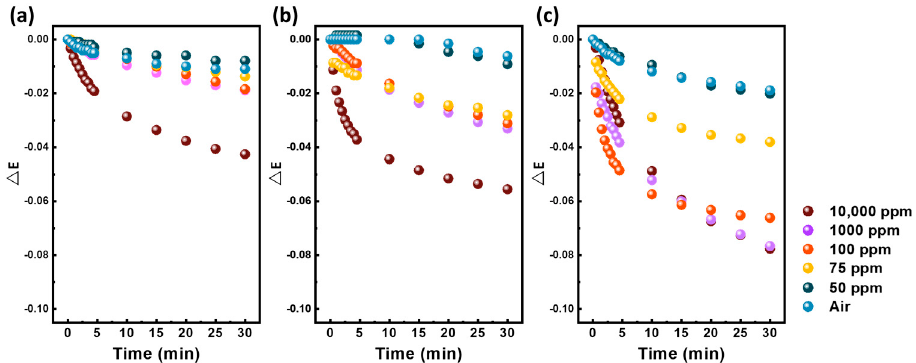
Figure 3. Extinction changes of ( a ) SnO 2 /Ag/PMMA fi bers ( b ) WO 3 /Ag/PMMA and ( c ) WO 3 /SnO 2 /Ag/PMMA sensing materials exposed to various concentrations of